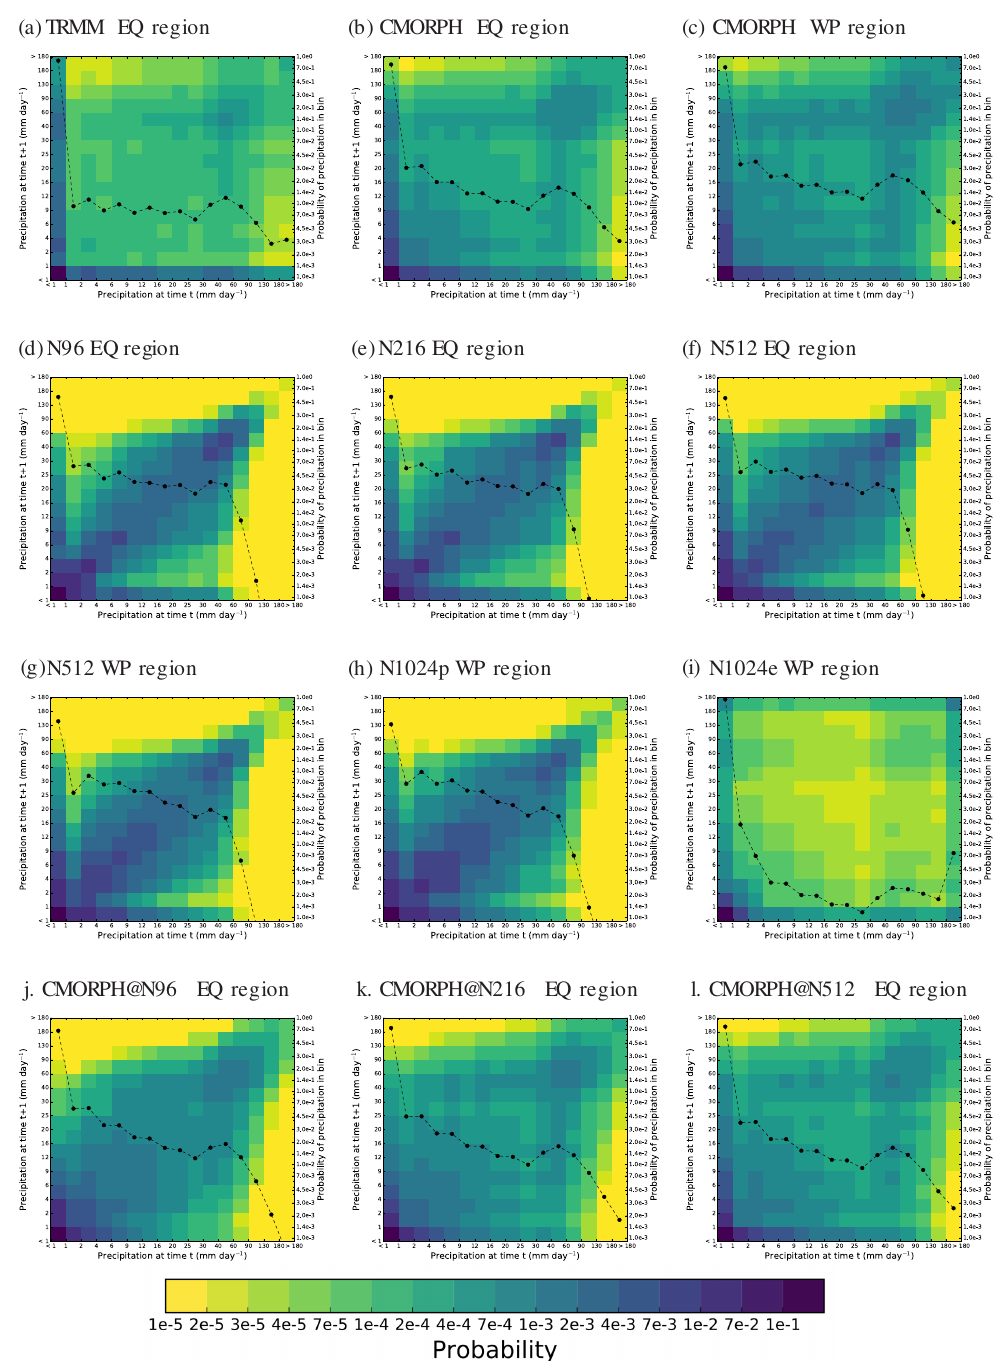
Figure 4. As in Fig. 2, but using 3h mean rain rates instead of time step rain rates, retaining the native horizontal grids. Panels (a–c) show 3-hourly CMORPH and TRMM data for JJAS 2005, using their native grids. CMORPH is shown for both EQ and WP to demonstrate the similarity between the regions. Panels (j–l) show CMORPH averaged to the N96, N216 and N512 MetUM resolutions, respectively, over the EQ region, to compare with panels (d–f)